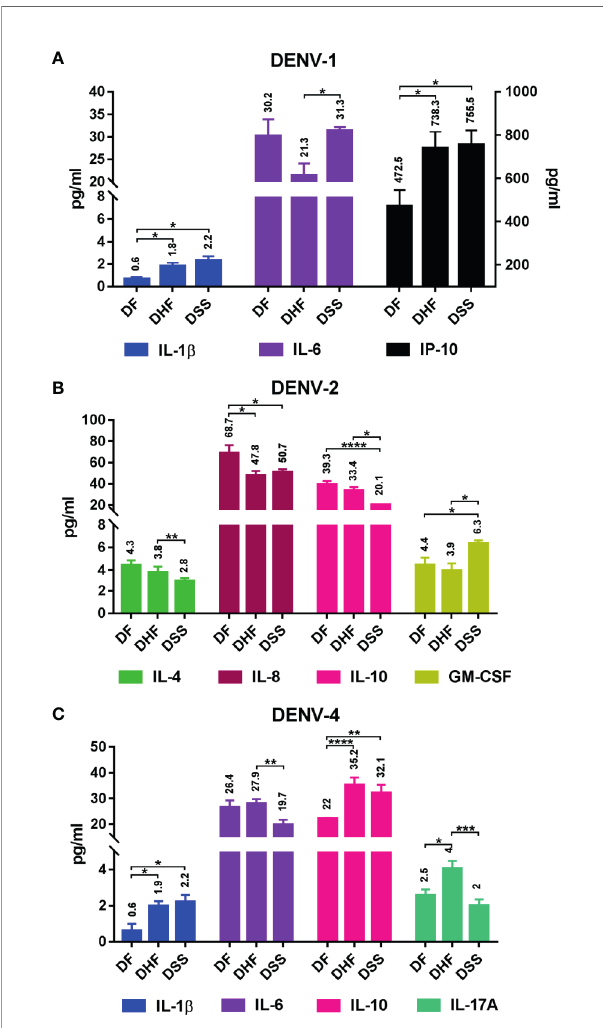
FIGURE 8 | Differential cytokine expression in each serotype with respect to dengue severity. The graph shows differential expression in each serotype: (A) DENV-1, (B) DENV-2, and (C) DENV-4. The differential cytokine expression was analyzed using Welch ’ s two-tailed t test within dengue severity in each serotype, and signi fi cant cytokines are shown here; IL-1 b , IL-6, and IP-10 show differential expression pattern in DENV-1 (A) ; IL-4, IL-8, IL-10, and GM-CSF show differential expression pattern in DENV-2 (B) ; and IL-1 b , IL-6, IL-10, and IL-17A show differential expression pattern in DENV-4 (C) . Statistical signi fi cance was shown in asterisk (*): * P < 0.05, ** p < 0.01, *** p < 0.001, **** p < 0.0001. The error bars represent SEM. [DF-DENV-1 (N=4), DENV-2 (N=14), DENV-4 (N=3); DHF-DENV-1 (N=5), DENV-2 (N=5), DENV-4 (N=21); DSS-DENV-1 (N=5), DENV-2 (N=3), DENV-4